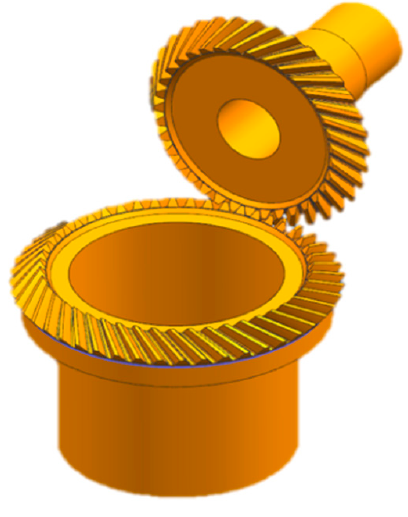
Figure 10. Geometric model of gear mesh.